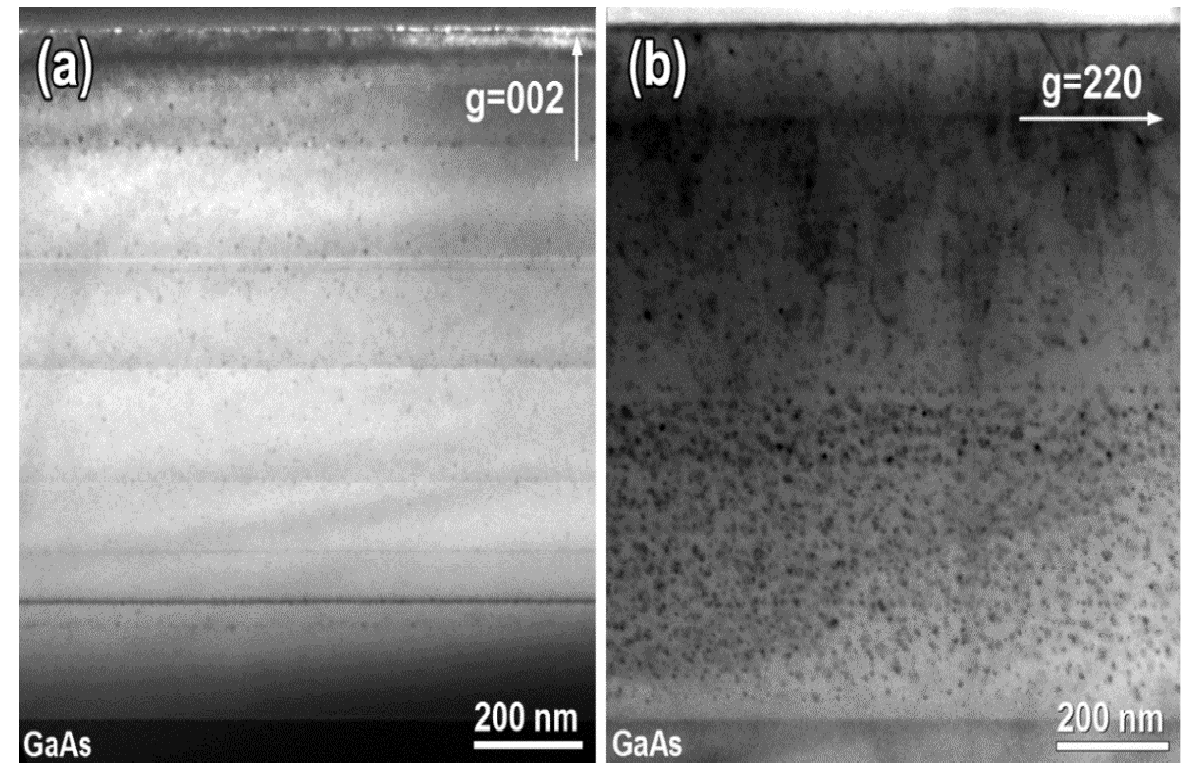
Figure 3. Cross-sectional TEM micrographs of ( a ) LT-Al 0.6 Ga 0.4 As (002 dark-field); ( b ) LT- Al 0.6 Ga 0.4 As 0.97 Sb 0.03 (220 bright-field) the samples annealed at 600 °C.